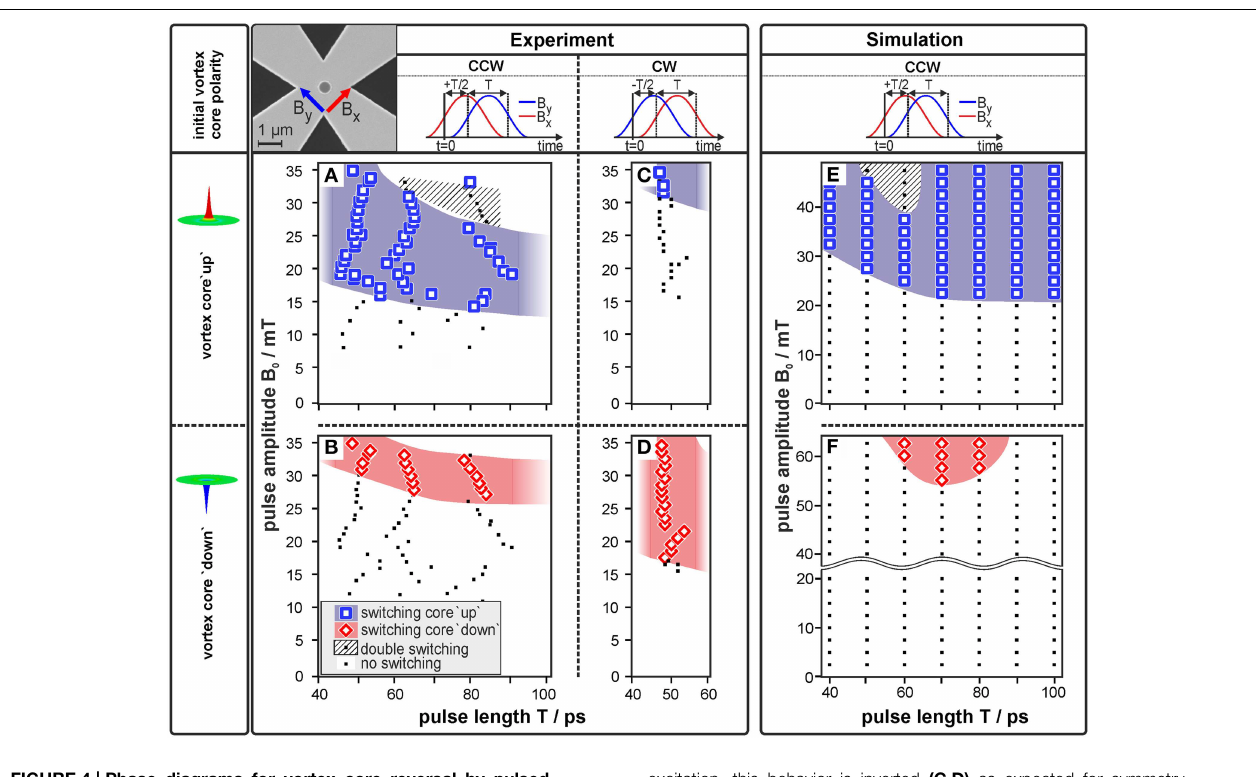
excitation, this behavior is inverted (C,D) as expected for symmetry reasons. A scanning electron microscope image of the crossed striplines with the Permalloy disk is shown in the upper left corner. The arrows indicate the directions of the magnetic field pulses as sketched in the upper